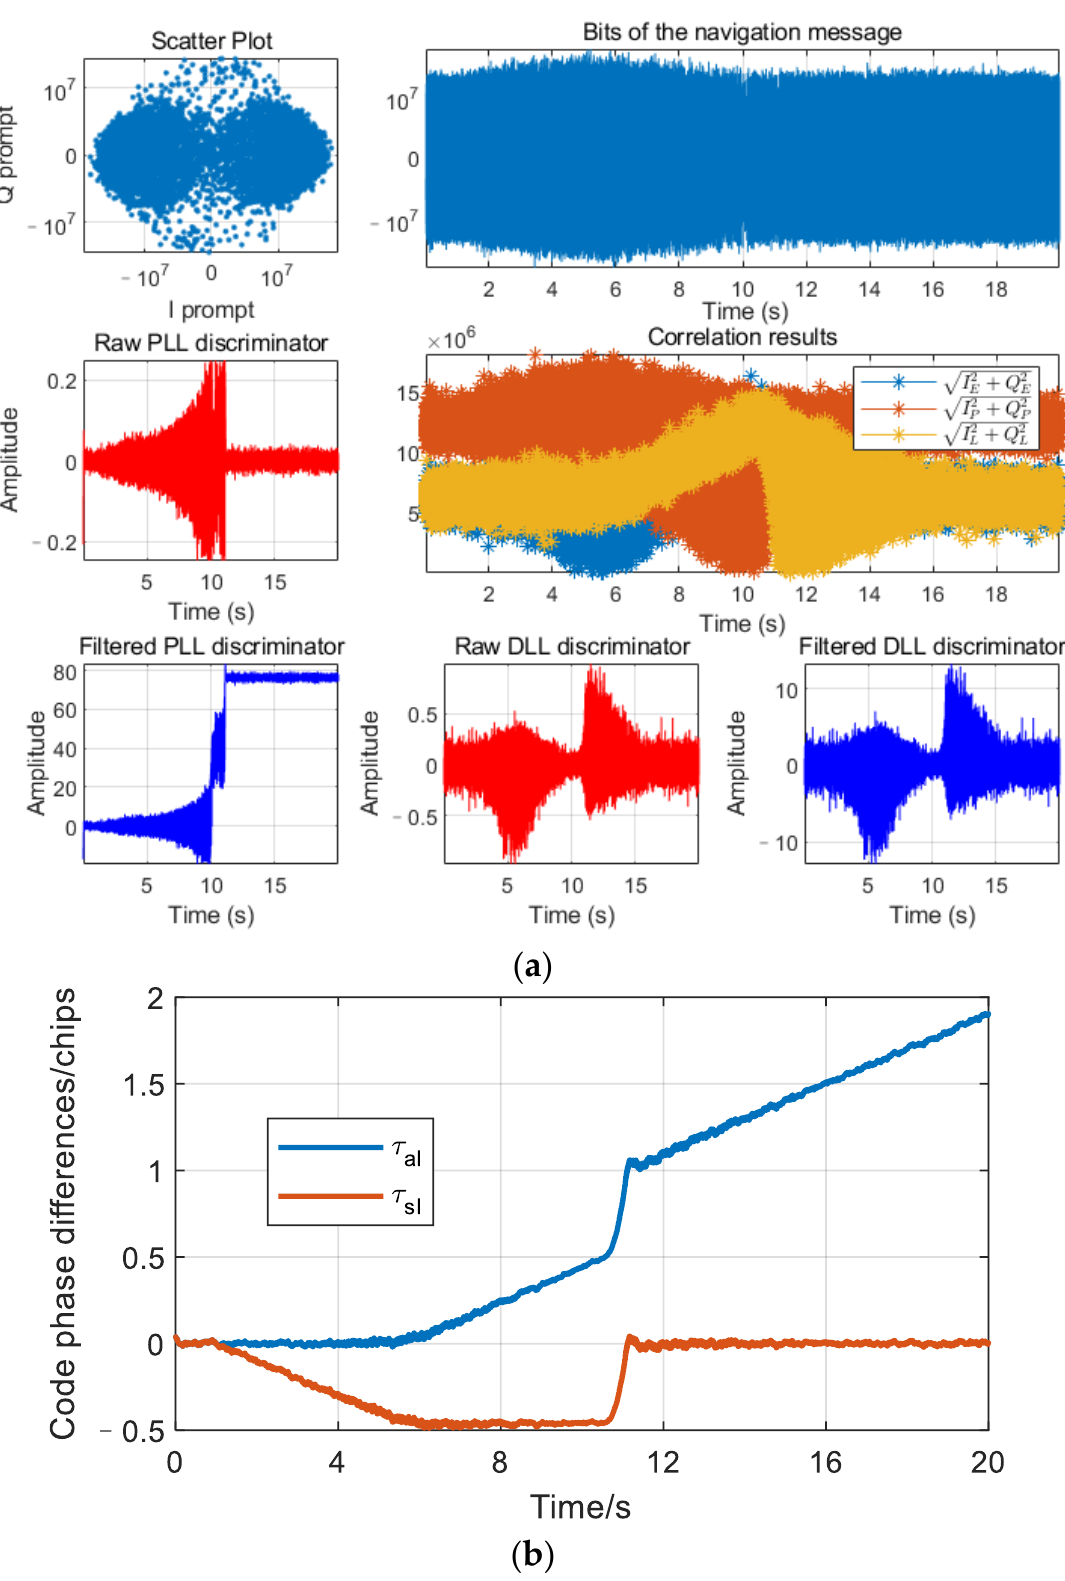
= 50 dBHz, D = 1 ). ( a ) Obtained results of Figure 15. Results of the conventional Strategy 2(C/N 0 = 50 dBHz, D = 1). ( a ) Obtained results of Figure 15. Results of the conventional Strategy 2( C/N 0 the software receiver; ( b ) Code phase the software receiver; ( b ) Code phase difference.